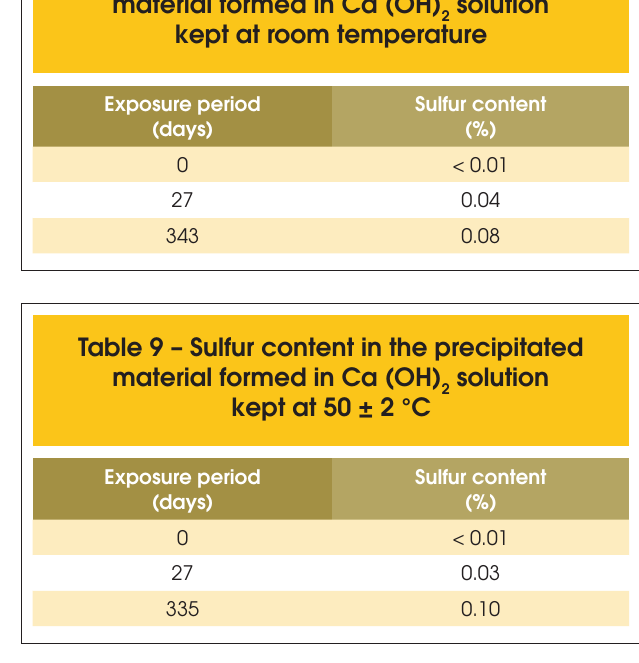
Table 8 – Sulfur content in the